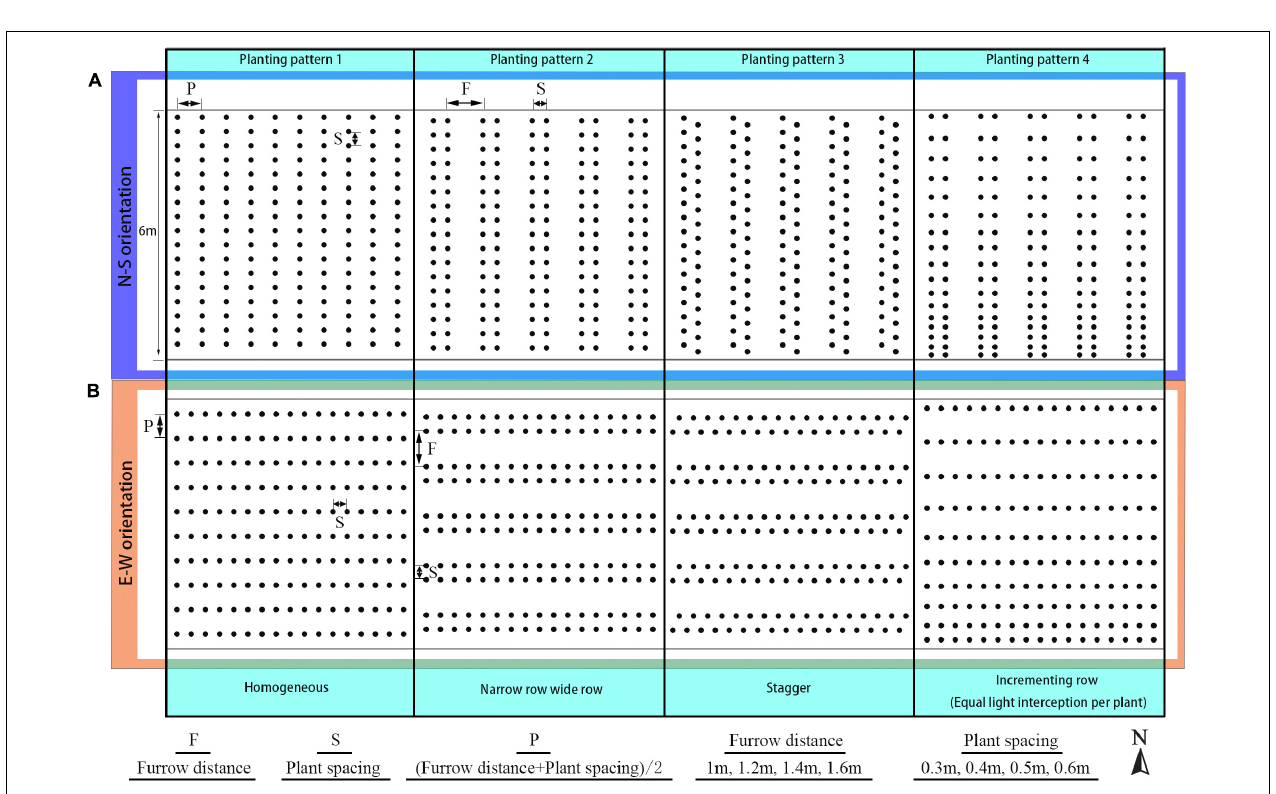
FIGURE 2 | Schematic representation of the N–S row (A) and E–W row orientation (B) with four planting patterns, namely: homogeneous (planting pattern 1), narrow row wide row (planting pattern 2), stagger (planting pattern 3), and incrementing row (planting pattern 4).